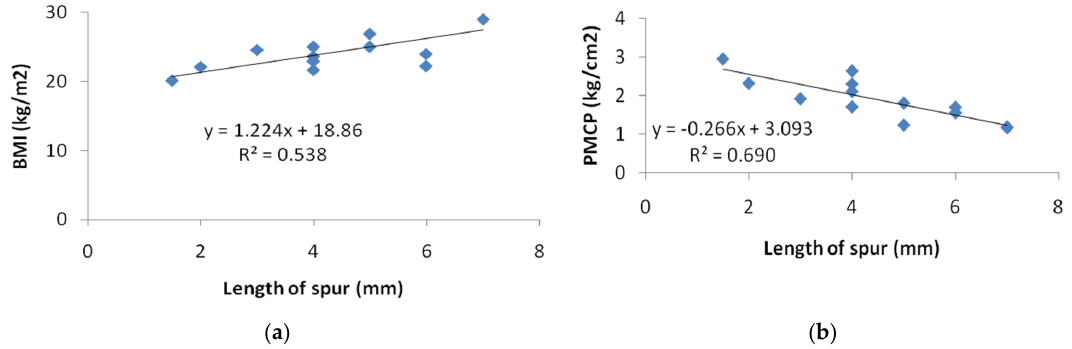
Figure 4. The correlation between lengths of spur with: ( a ) Body mass index (BMI); and ( b ) Pain minimum compressive pressure (PMCP).